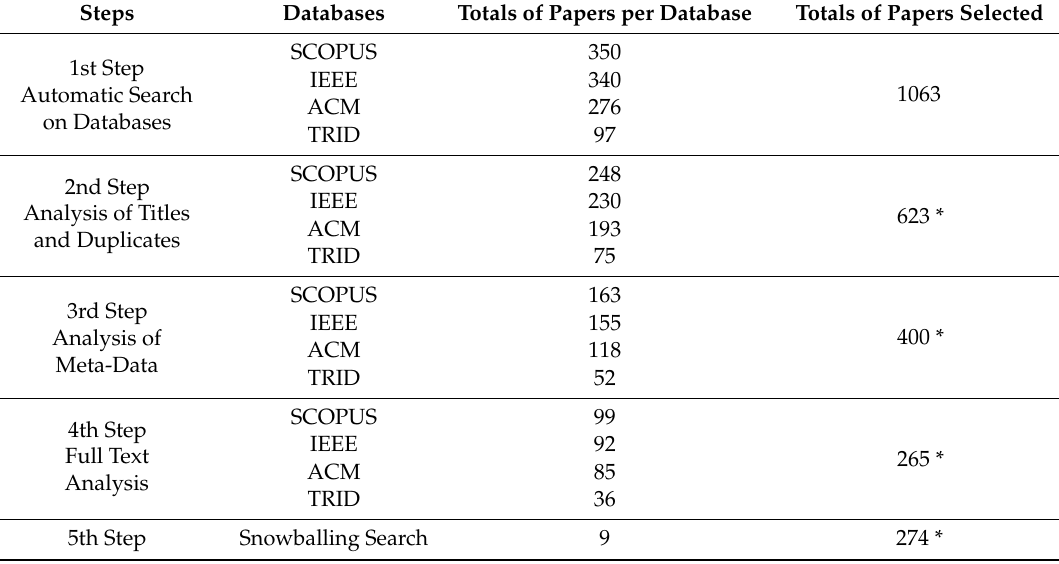
Table 4. Totals of primary papers selected of each